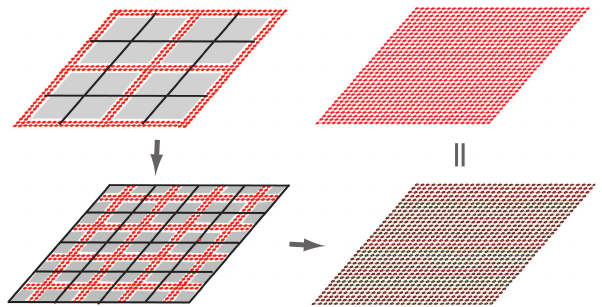
Fig. 12. Schematic illustration of the convergence of the Q3-D MMF grid to a 3-D CRM grid.